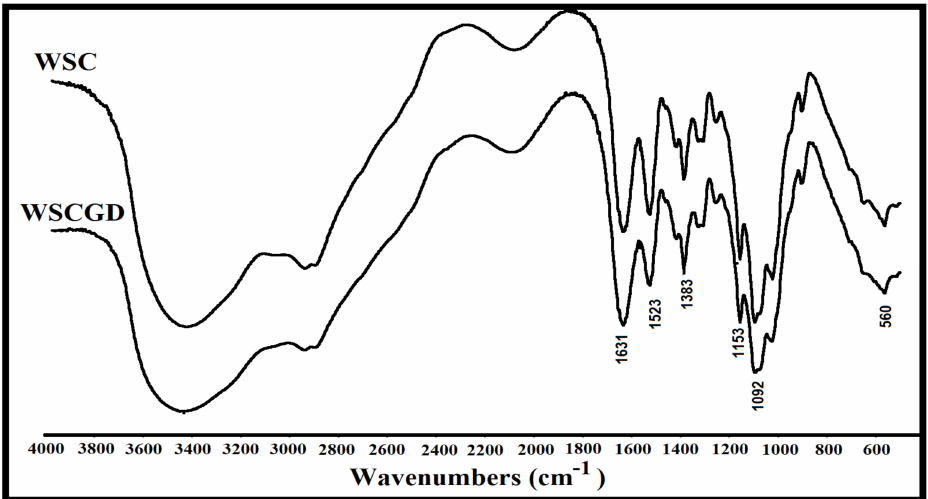
Figure 4. Typical FTIR profiles of WSC and